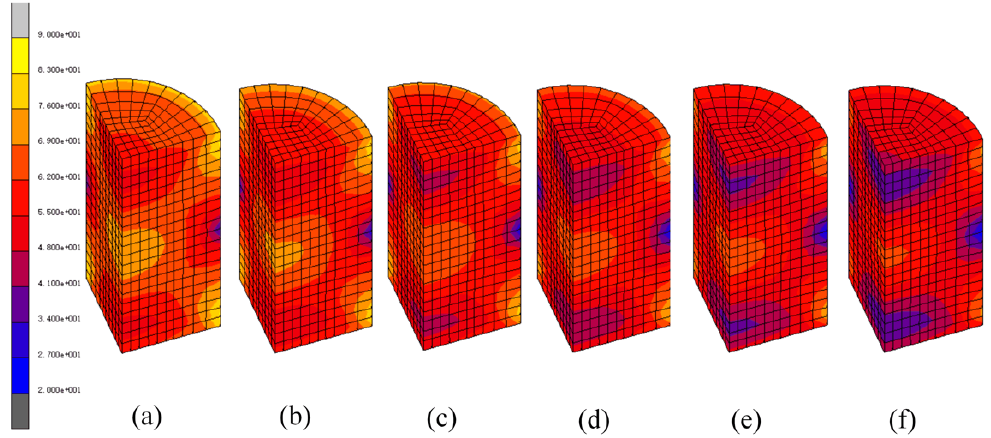
Figure 12. Equivalent von Mises stress distributions in powder compacts at P = 200 MPa for Al contents of ( a ) 15 wt %, ( b ) 20 wt %, ( c ) 25 wt %, ( d ) 30 wt %, ( e ) 35 wt %, and ( f ) 40 wt %.